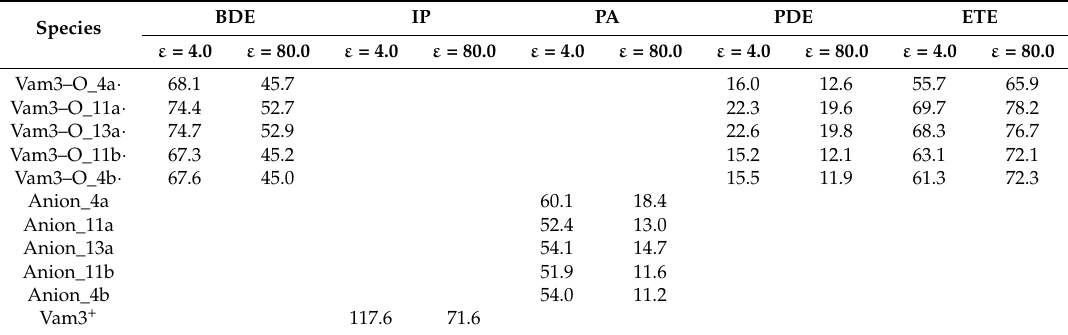
Table 1. BDE, IP, PDE, PA and ETE values (in kcal/mol) of Vam3 derived species for HAT, SET-PT and SPLET mechanisms in an apolar solvent ( ε = 4) and in water ( ε =